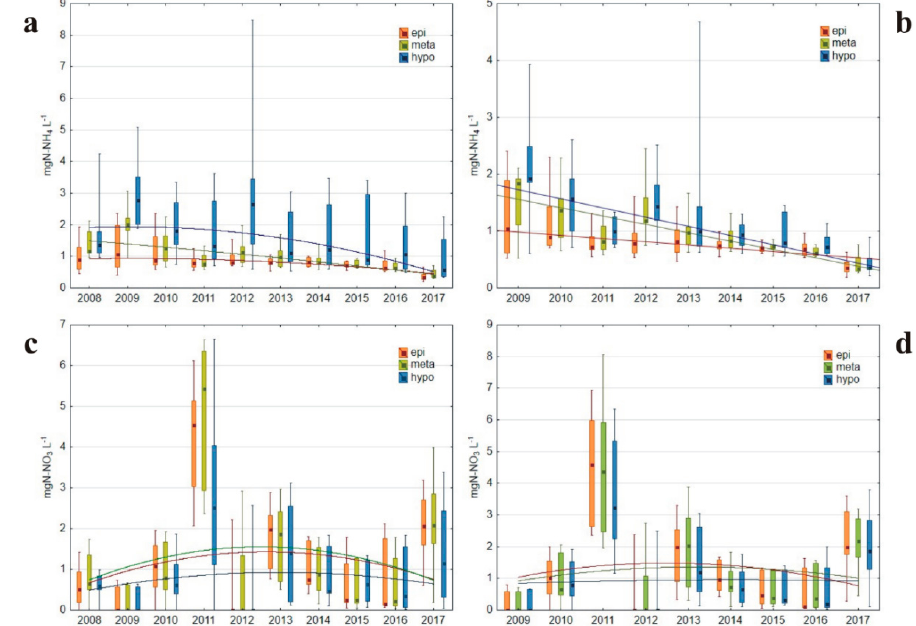
Figure 8. Box plot with min-max of mineral nitrogen compounds in selected water layers: ammonium N at Station I ( a ) and Station II ( b ); and nitrate nitrogen at Station I ( c ) and Station II ( d ). The lines indicate binomial trendlines for water layers in ( a , c , d ), and linear trend in ( b ). Water 2019 , 11 , x FOR PEER REVIEW